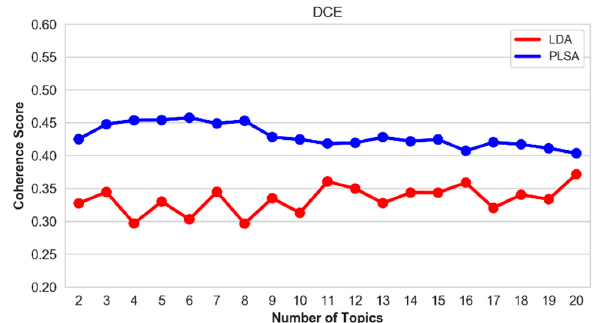
Figure 19. Coherence score of the top-20 topics on the TPI hallmark.